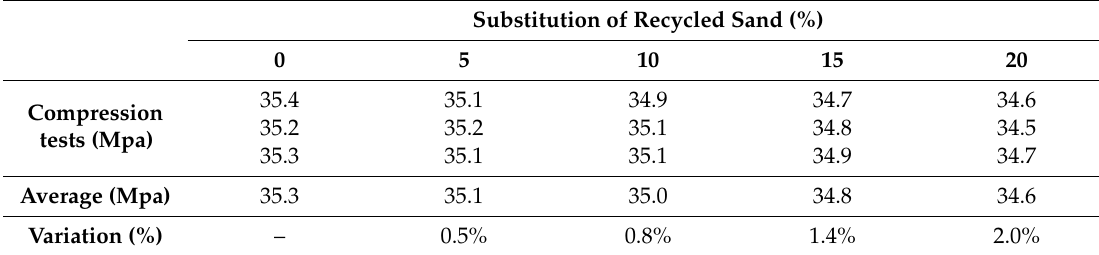
Table 9. Compression tests results.